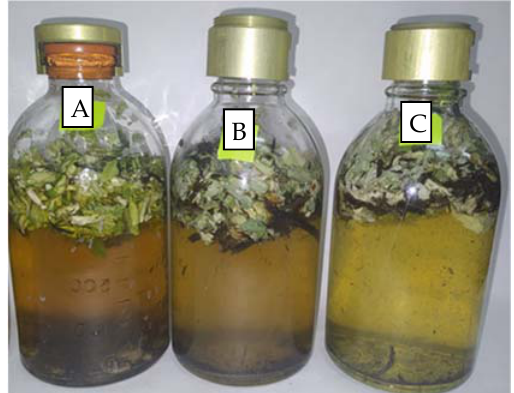
Figure 3. General view of the sealed glass jars with a total volume of 500 mL: ( A ) control variant without preparations; ( B ) with GMP1 modification containing living hydrogen-synthesizing microor- ganisms; ( C ) with GMP2 modification containing living methane-synthesizing